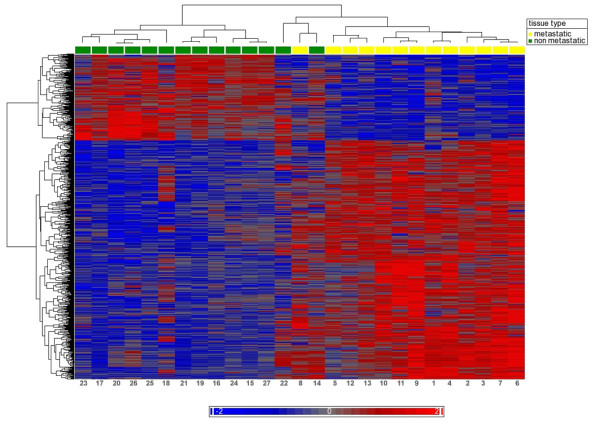
Two dimensional cluster analysis of metastatic versus non-metastatic canine mammary tumors. Two of the lymph node metastasis-negative carcinomas were adjoined to the metastatic tumor cluster. One of these animals (no. 22) developed lung metastases 8 months after initial surgery despite negative lymph-node status.